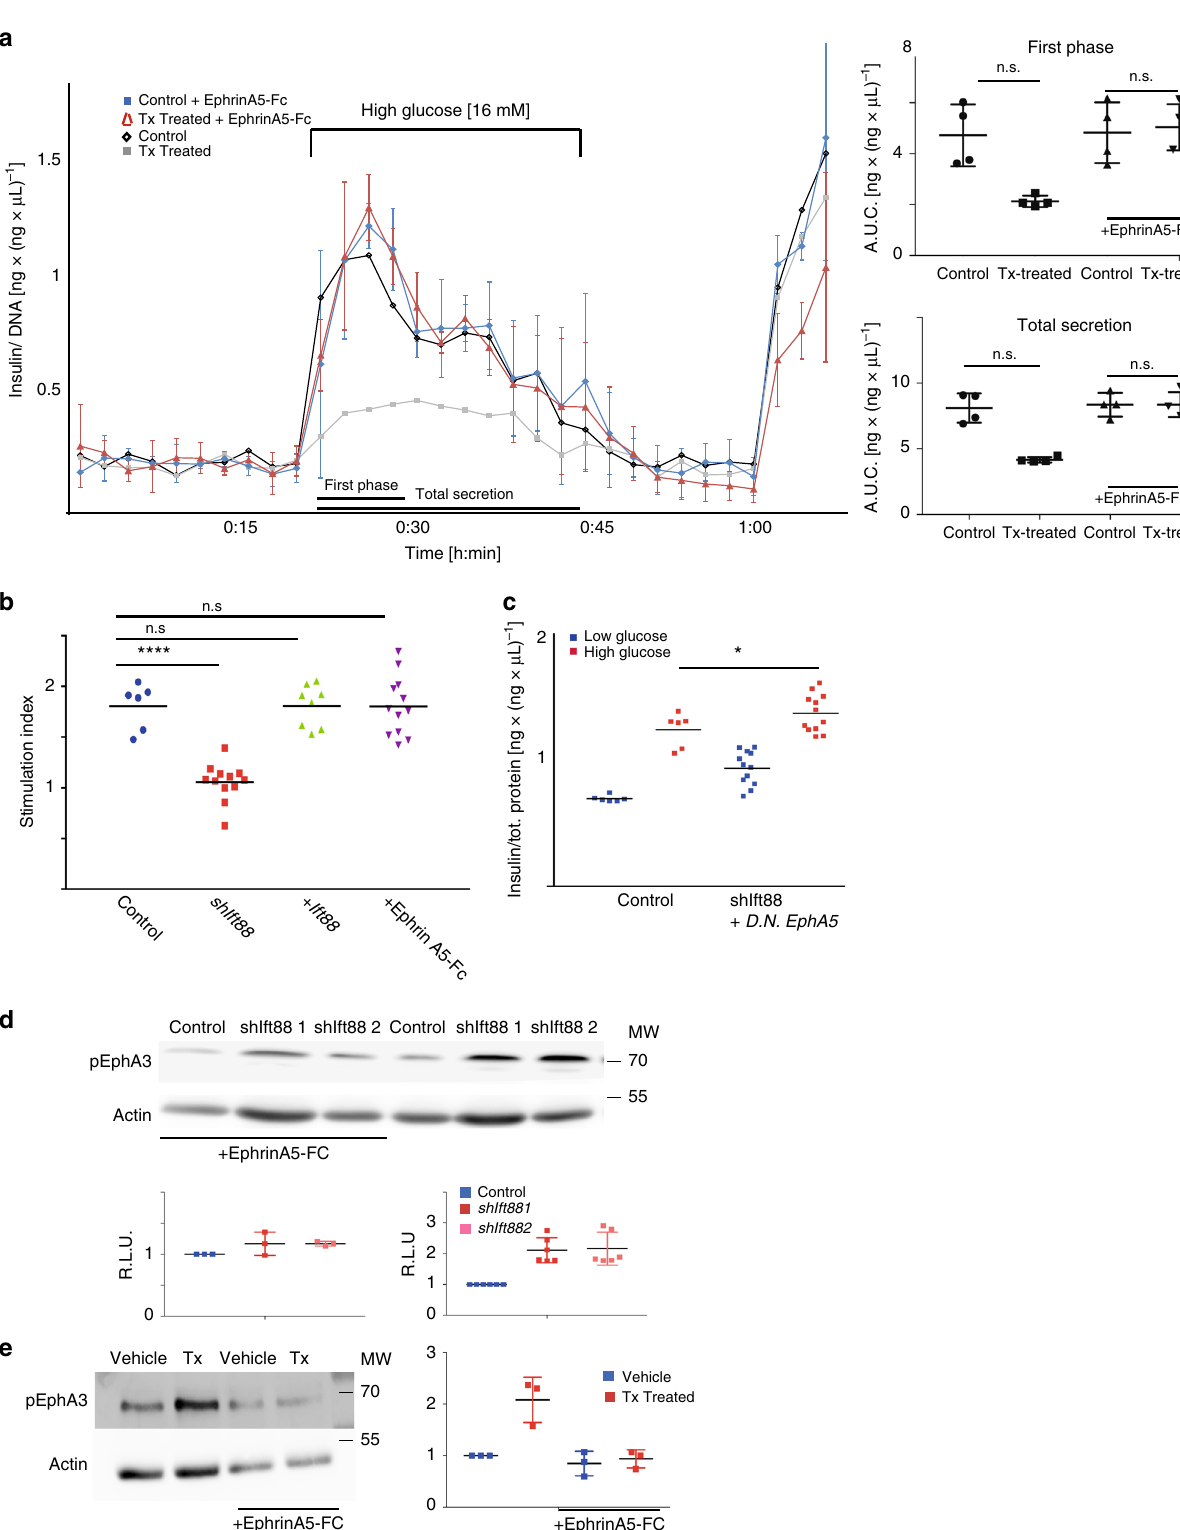
reduction in pEphA3 in the presence or absence of Ift88 mRNA, 1 h after EphrinA5-Fc addition (Fig. 3d; Supplementary Fig. 5a). The relative difference of pEphA3 levels in both EphrinA5-Fc- treated shIft88 -expressing clonal cell lines was reduced compared with basal conditions (Fig. 3d; shIft88 1 = 211% compared with control, shIft88 2 = 216% compared with control ( n = 6); shIft88 +